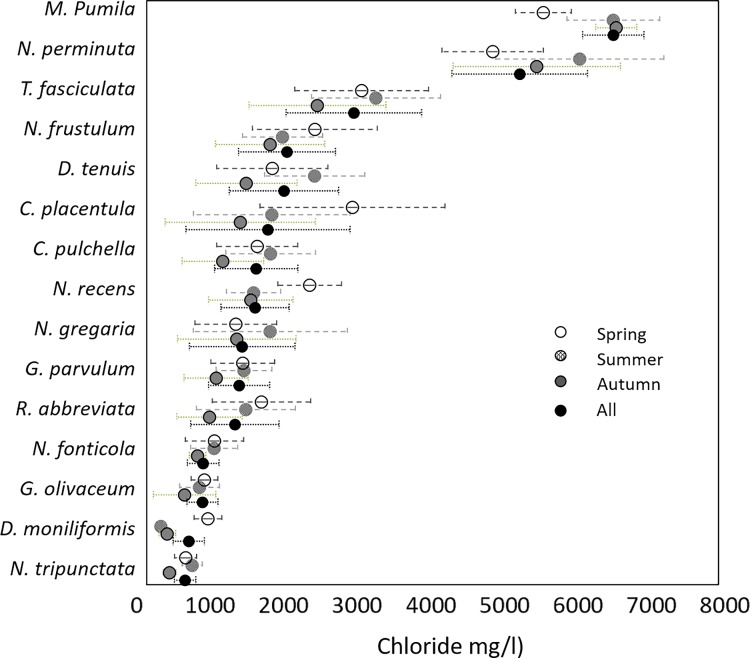
Optima (dots) and tolerances (error bars) of the species that contributed the most to community dissimilarity in the four models: Spring, summer, autumn and all (the three seasons combined).